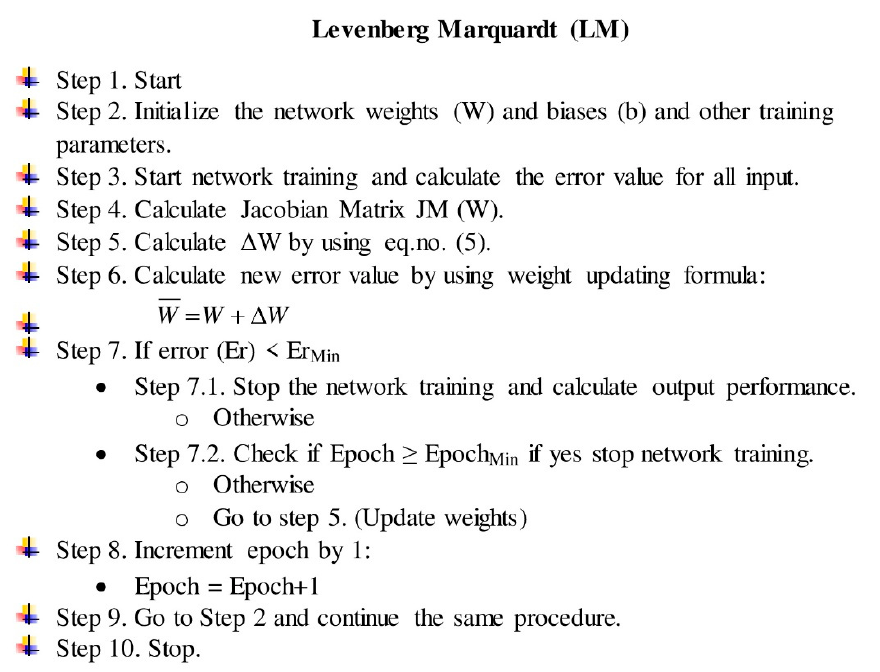
Figure 2. Stepwise Levenberg–Marquardt algorithm procedure.